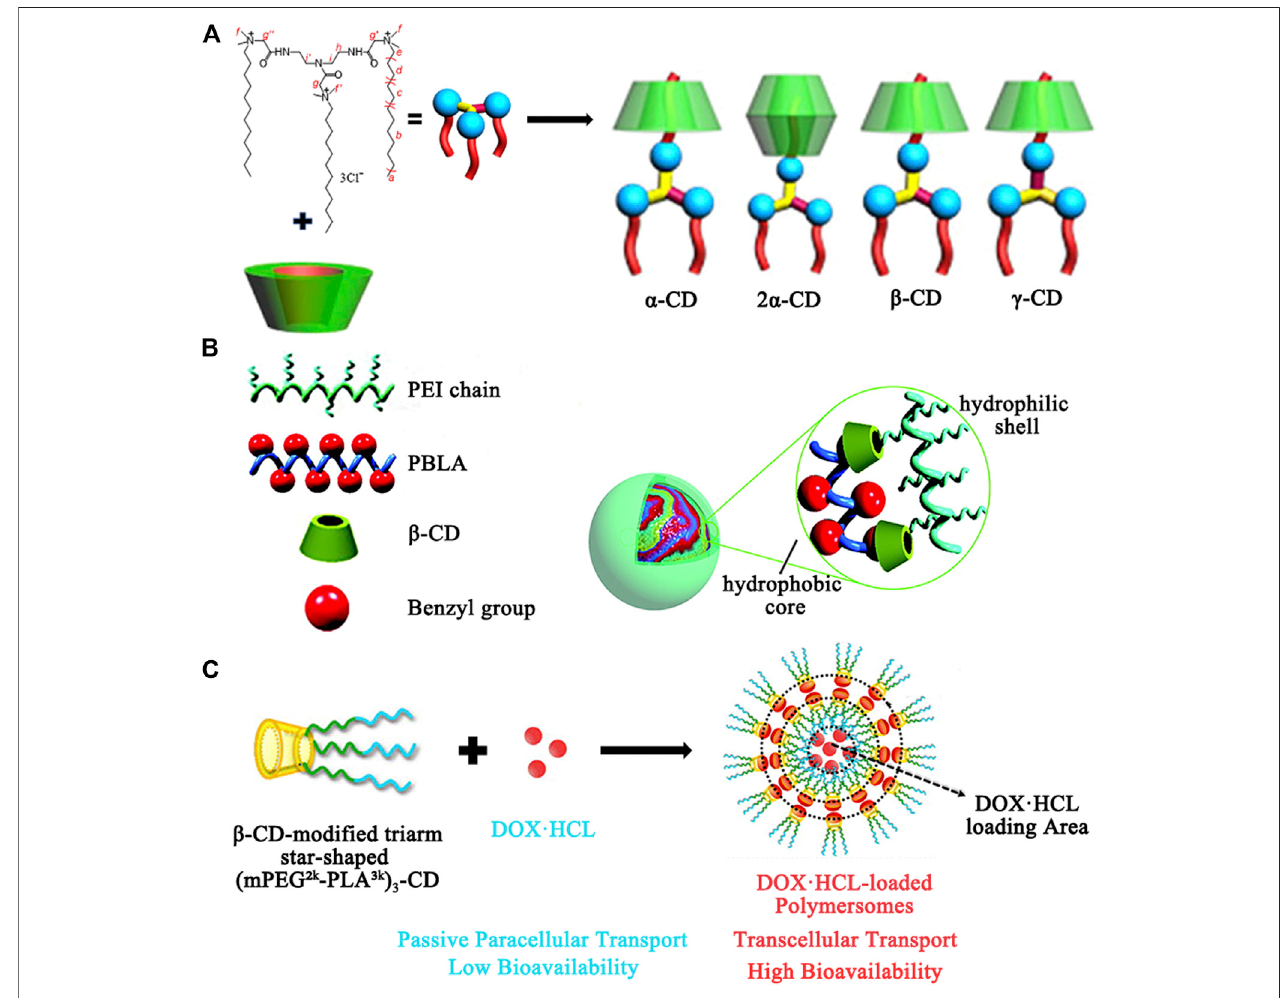
FIGURE3|(A) IllustrationofstructureofthecomplexesofCDsandDTAD. (B) Illustrationofstructureofthecore-shellnanoassembliesbasedonPEI-CD/PBLAby a host-guest interaction for dexamethasone delivery. (C) Illustration of the structure and the property of the polymersome for carrying DOX · HCl.